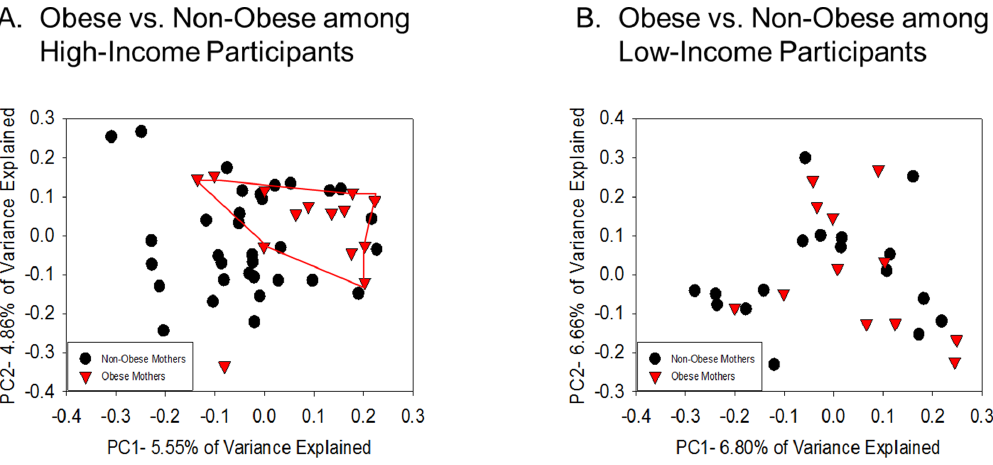
Figure 2. Interactive effects of maternal obesity and socioeconomic status were observed; effects of maternal obesity on the child microbiome were primarily seen among the higher SES group. A) In the higher income group, children born to obese versus non-obese mothers clustered (adonis, p=0.041) and had higher homogeneity (permdisp, p=0.003). B) These effects of maternal obesity were not seen in children in the lower income group.